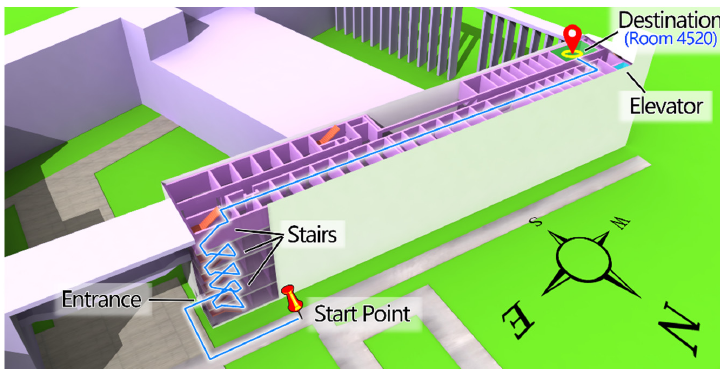
Figure 9. An example of seamless indoor–outdoor navigation.